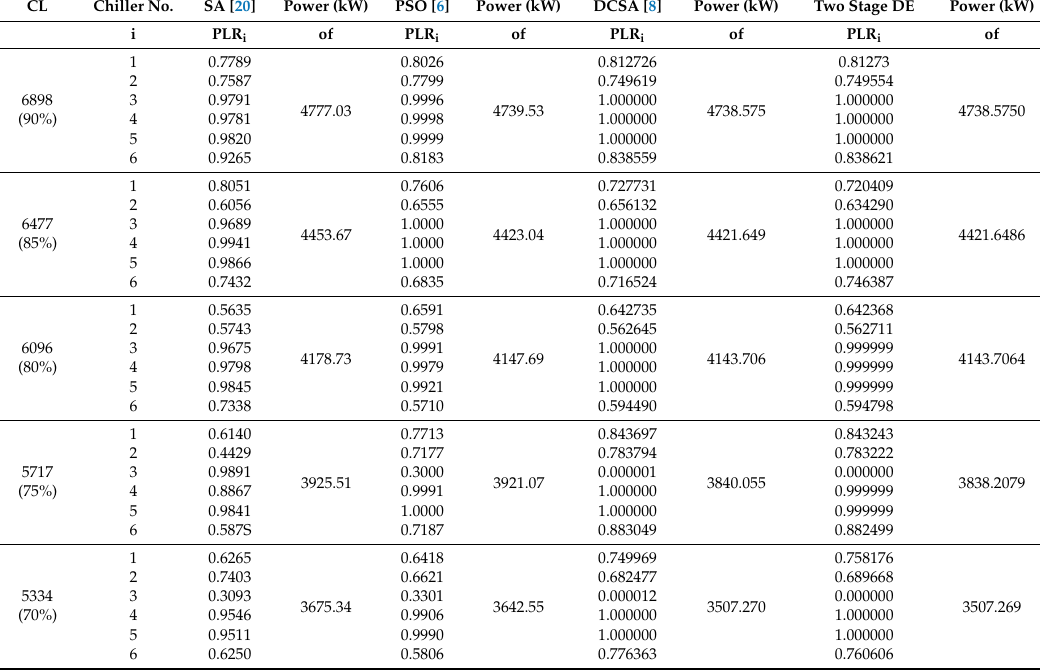
Table 3. Case study 1: comparison with methods proposed by other